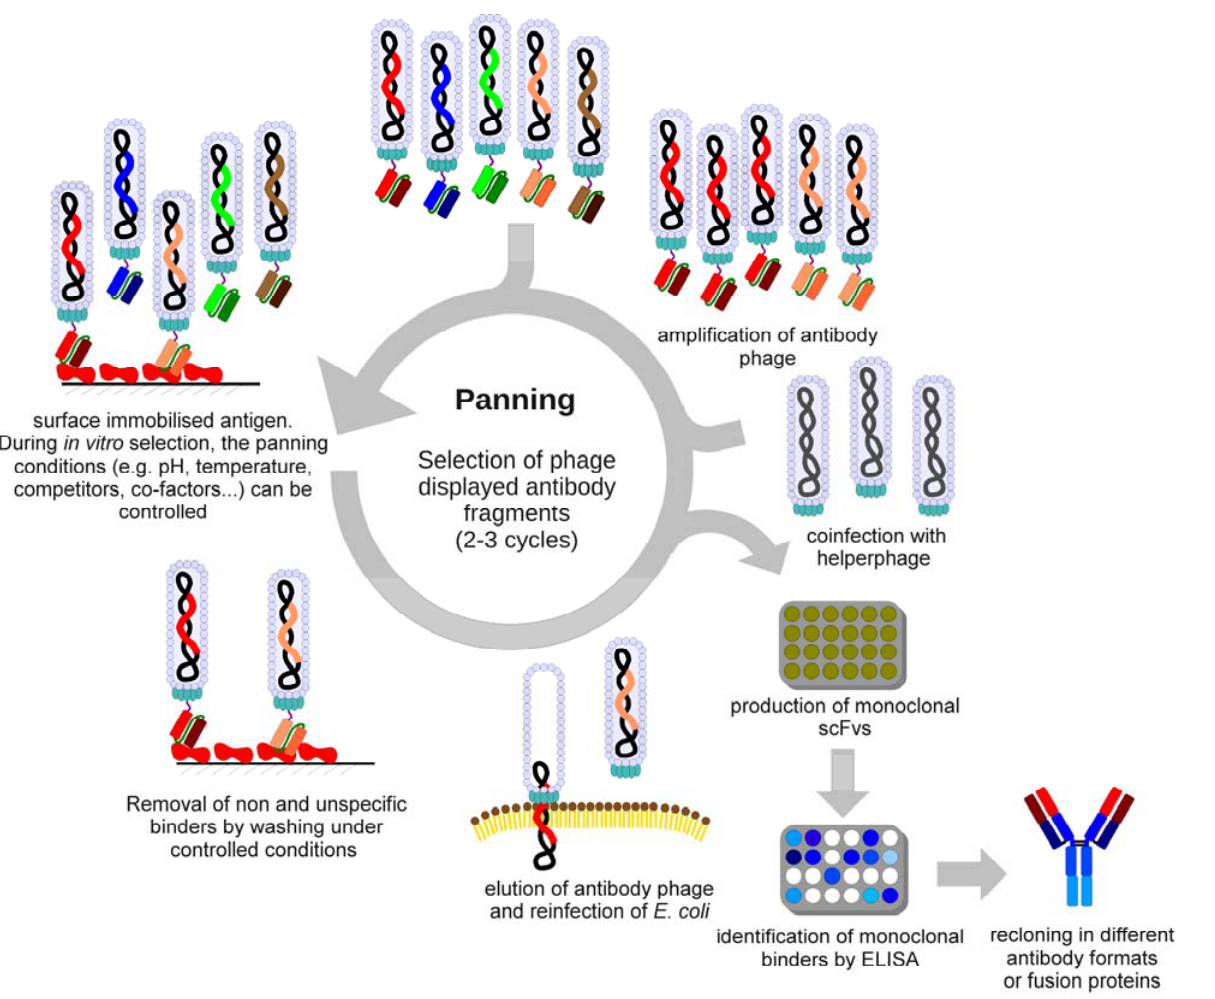
Figure 1. Schematic overview of the selection of antibodies (“panning“) by phage